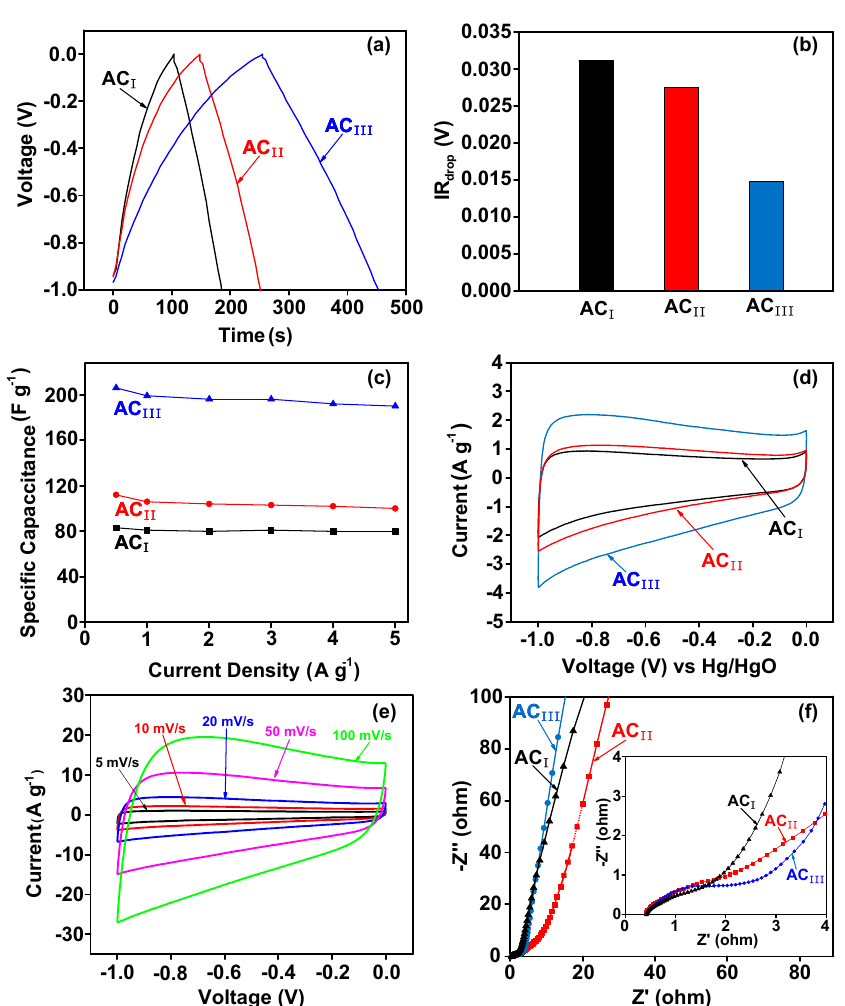
Figure 6. ( a ) Galvanostatic charge-discharge (GCD) curves of AC electrodes in 6 M KOH electrolyte at 1 A g − 1 ; ( b ) The voltage drops of AC electrodes at 1 A g − 1 ; ( c ) Specific capacitance of AC electrodes at di ff erent current densities; ( d ) CV curves of AC electrodes at 10 mV s − 1 ; ( e ) CV curves of AC III electrodes at di ff erent scan rates; ( f ) Nyquist plots of AC electrodes.